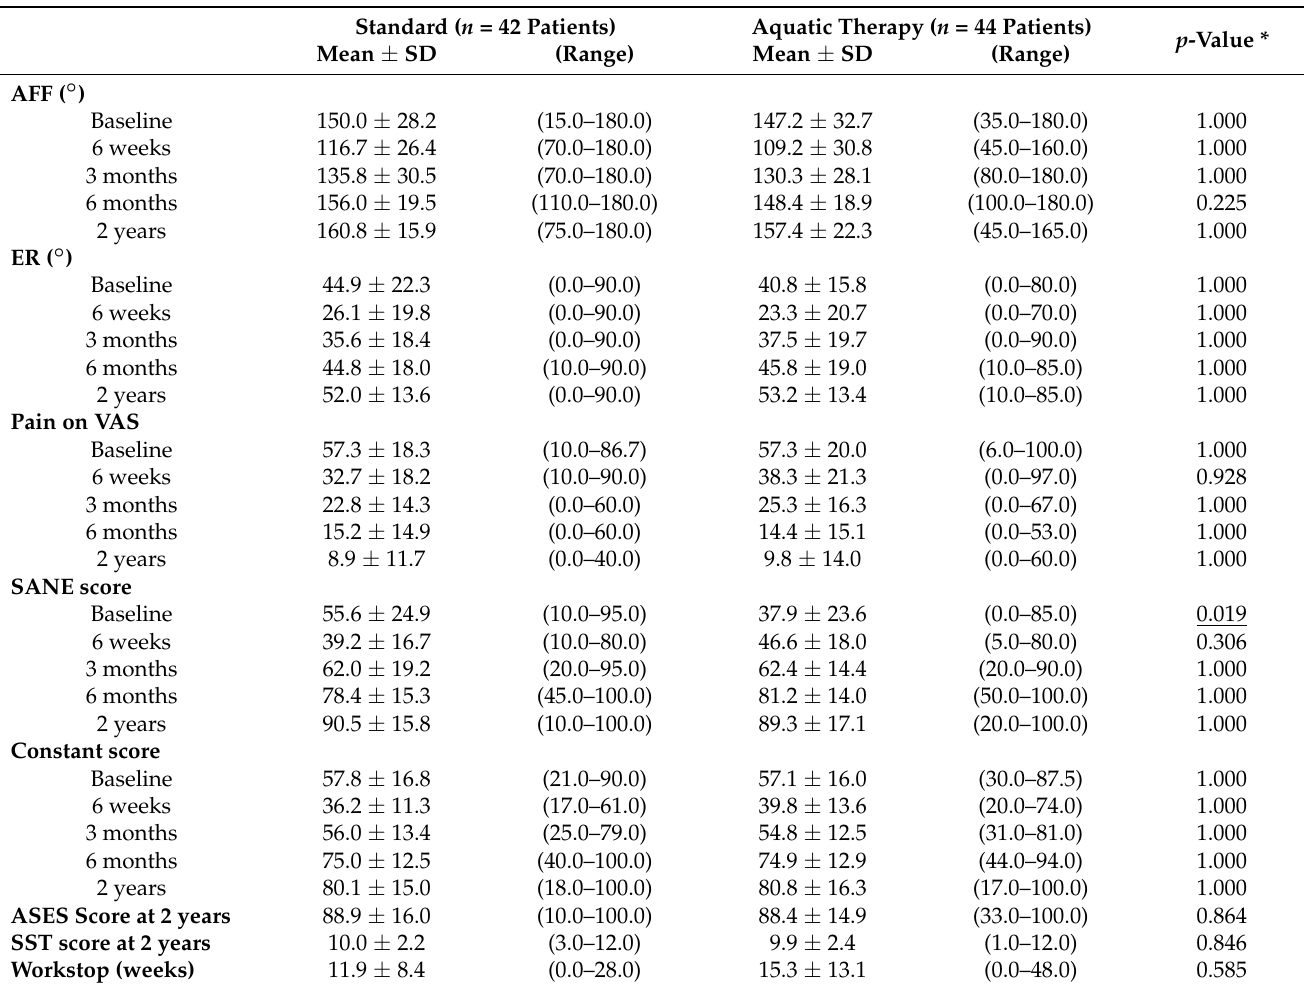
Table 2. Comparisons of pre- and post-operative clinical outcomes between the standard or aquatic therapy groups.